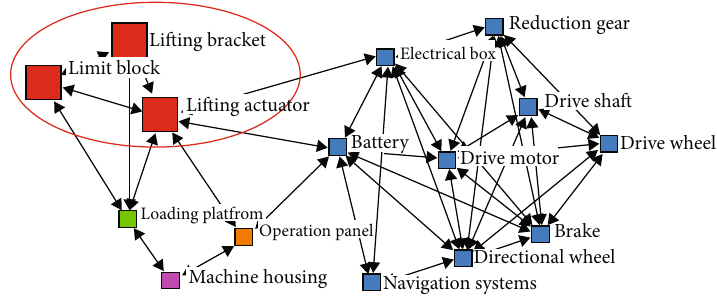
Figure 9: The network structure of the AGV.